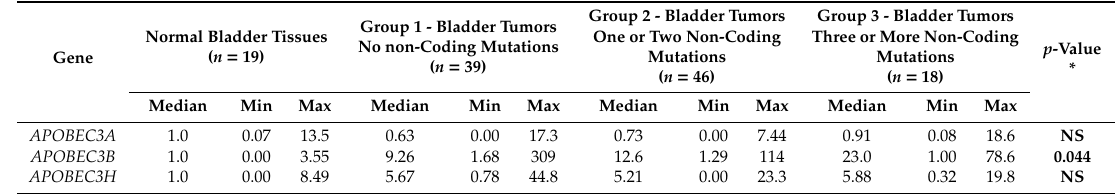
Table 4. Associations between TGAACA core motif mutations and mRNA expression levels of APOBEC3 genes. Group 3 - Bladder Tumors Group 2 - Bladder Tumors Group 1 - Bladder Tumors Three or More Non-Coding One or Two Non-Coding Normal Bladder Tissues No non-Coding Mutations p -Value Mutations Mutations ( n = 19) Gene ( n = 39) * ( n = 18) ( n = 46) Median Min Max Median Min Max Median Min Max Median Min Max APOBEC3A 1.0 0.07 13.5 0.63 0.00 17.3 0.73 0.00 7.44 0.91 NS APOBEC3B 1.0 0.00 3.55 9.26 1.68 309 12.6 1.29 114 23.0 1.00 78.6 0.044 APOBEC3H 1.0 0.00 8.49 5.67